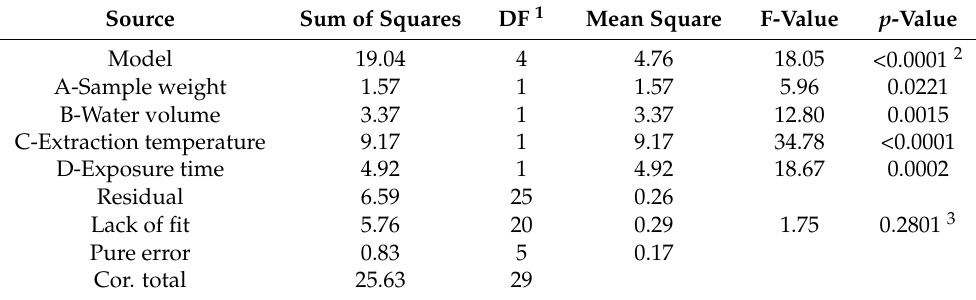
Table 2. Analysis of variance results for the experimental